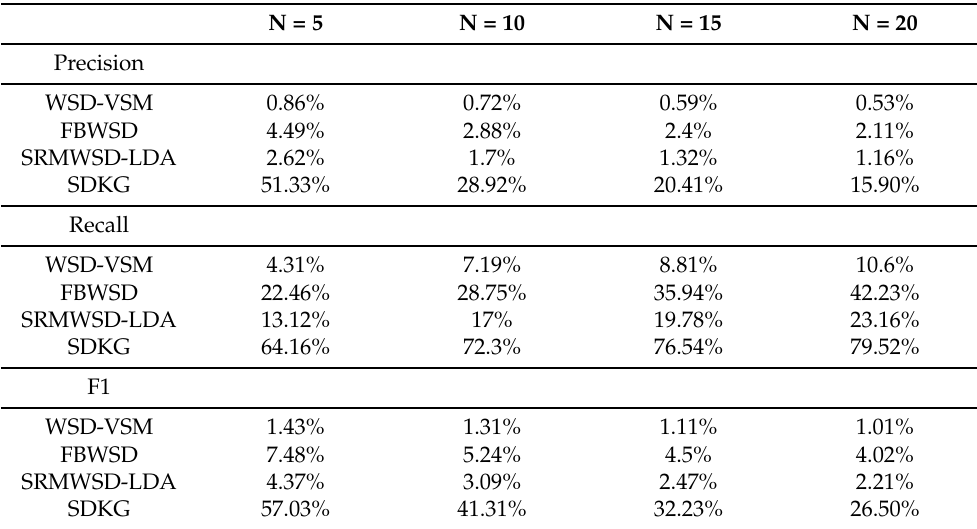
Table 3. Indicator results of four service discovery